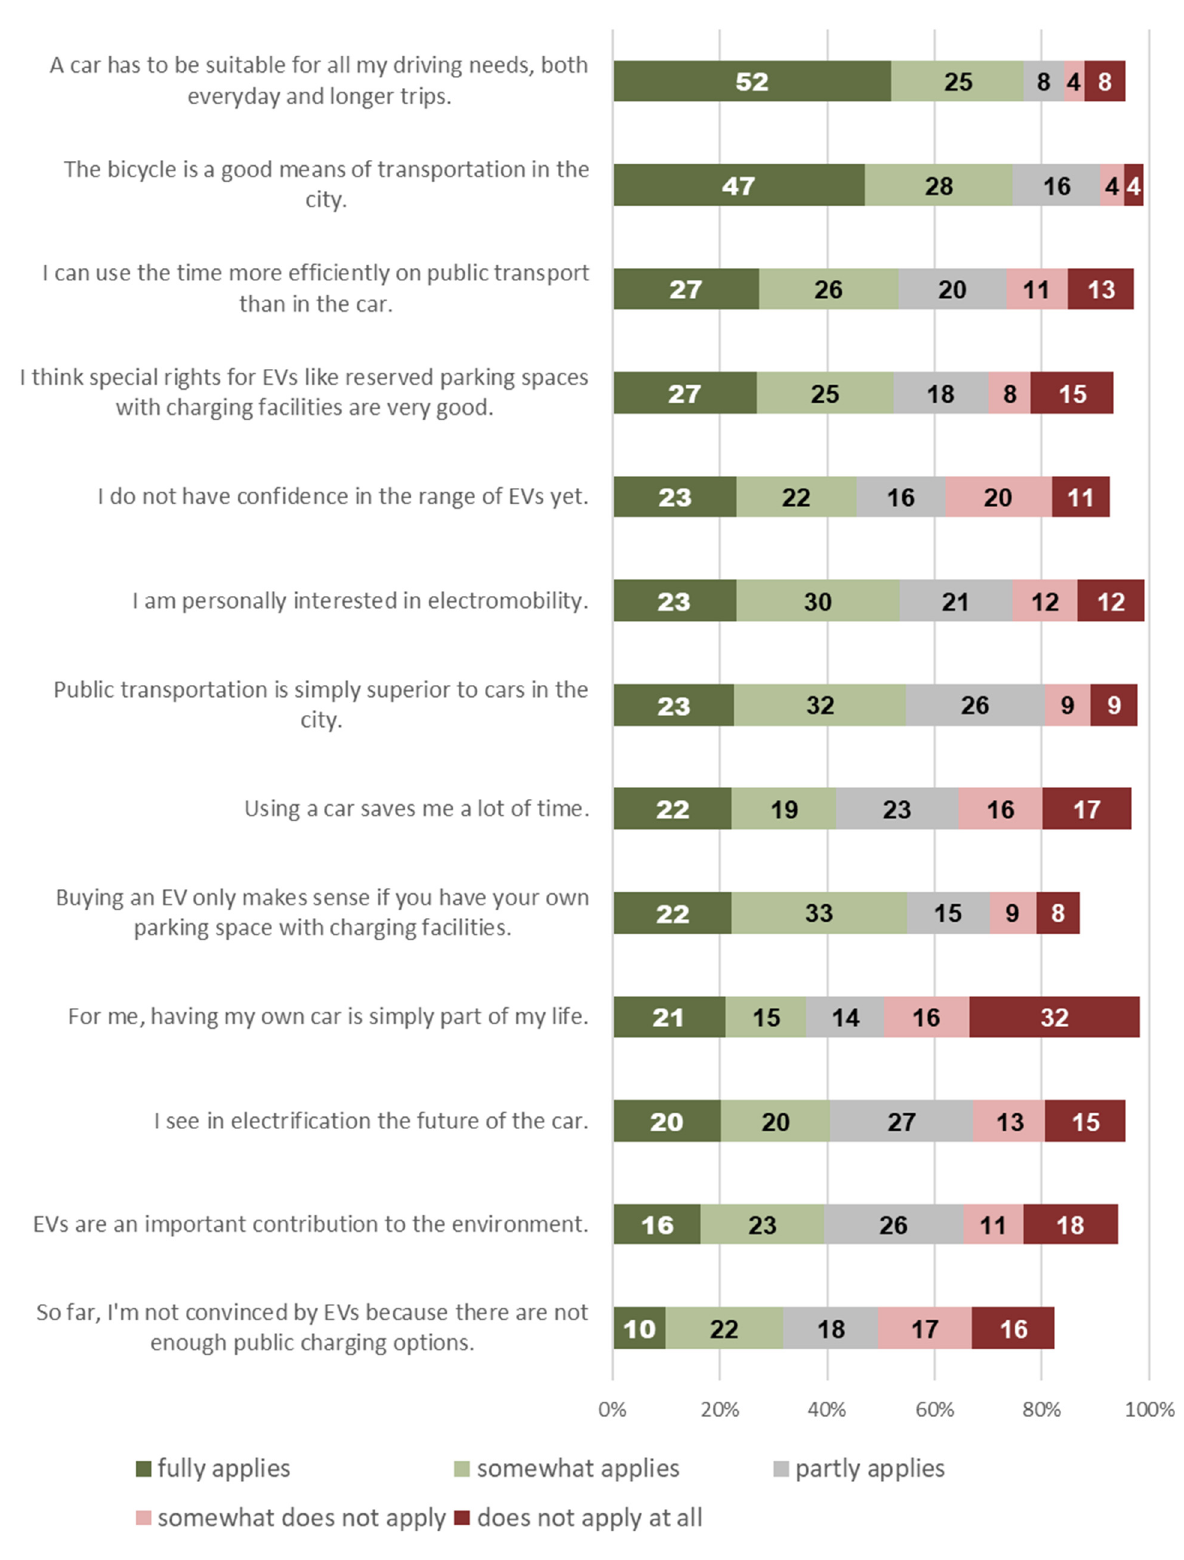
Figure 1. Attitudes towards electromobility and different means of transportation. The values missing to create 100% in each row represent ”cannot